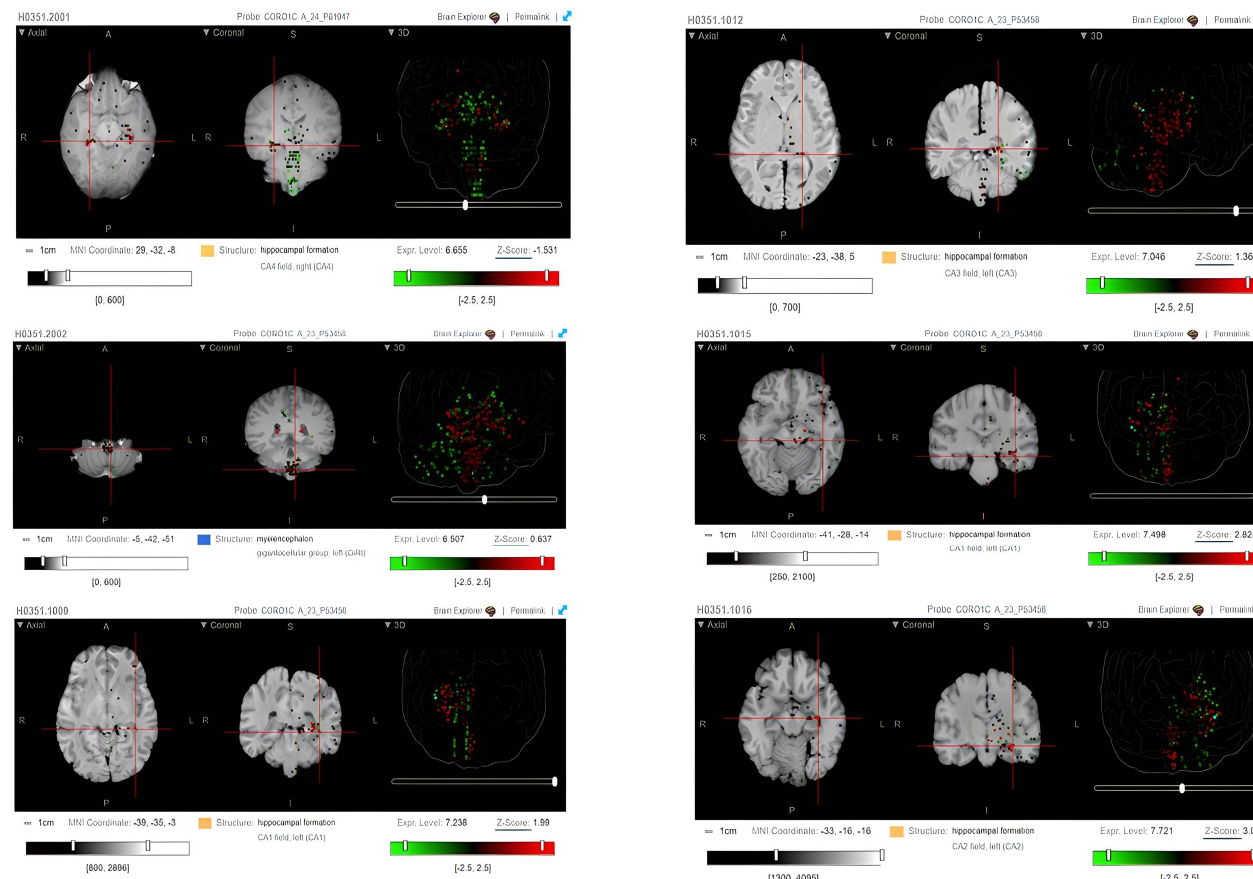
Figure 2. Heatmaps of log2 expression values of six patients obtained from microarrays experiments (Allen brain atlas). The Allen brain atlas database revealed that CORO1C is highly expressed within the hippocampal formation and myelencephalon regions of the brain